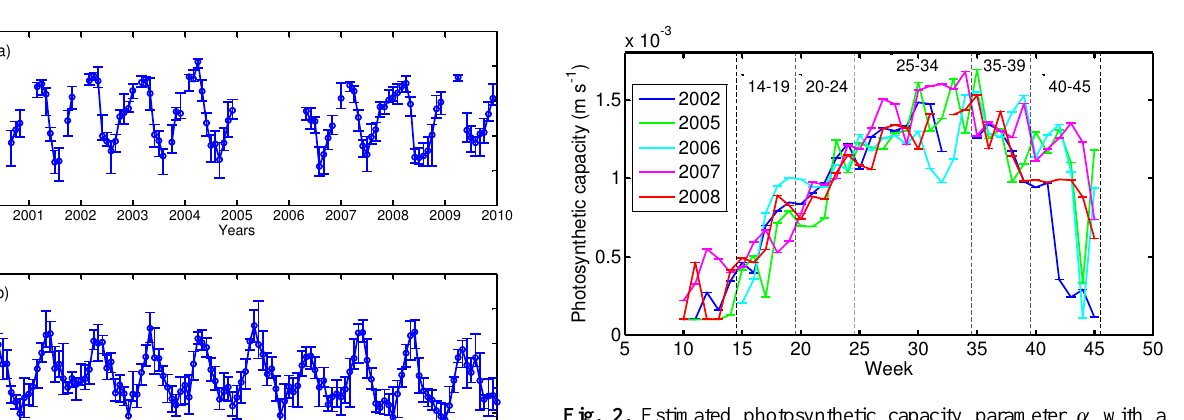
Fig. 2. Estimated photosynthetic capacity parameter α with a weekly interval for the selected years from 2001 till 2010, for day- time observations as defined by h 0 >10 ◦